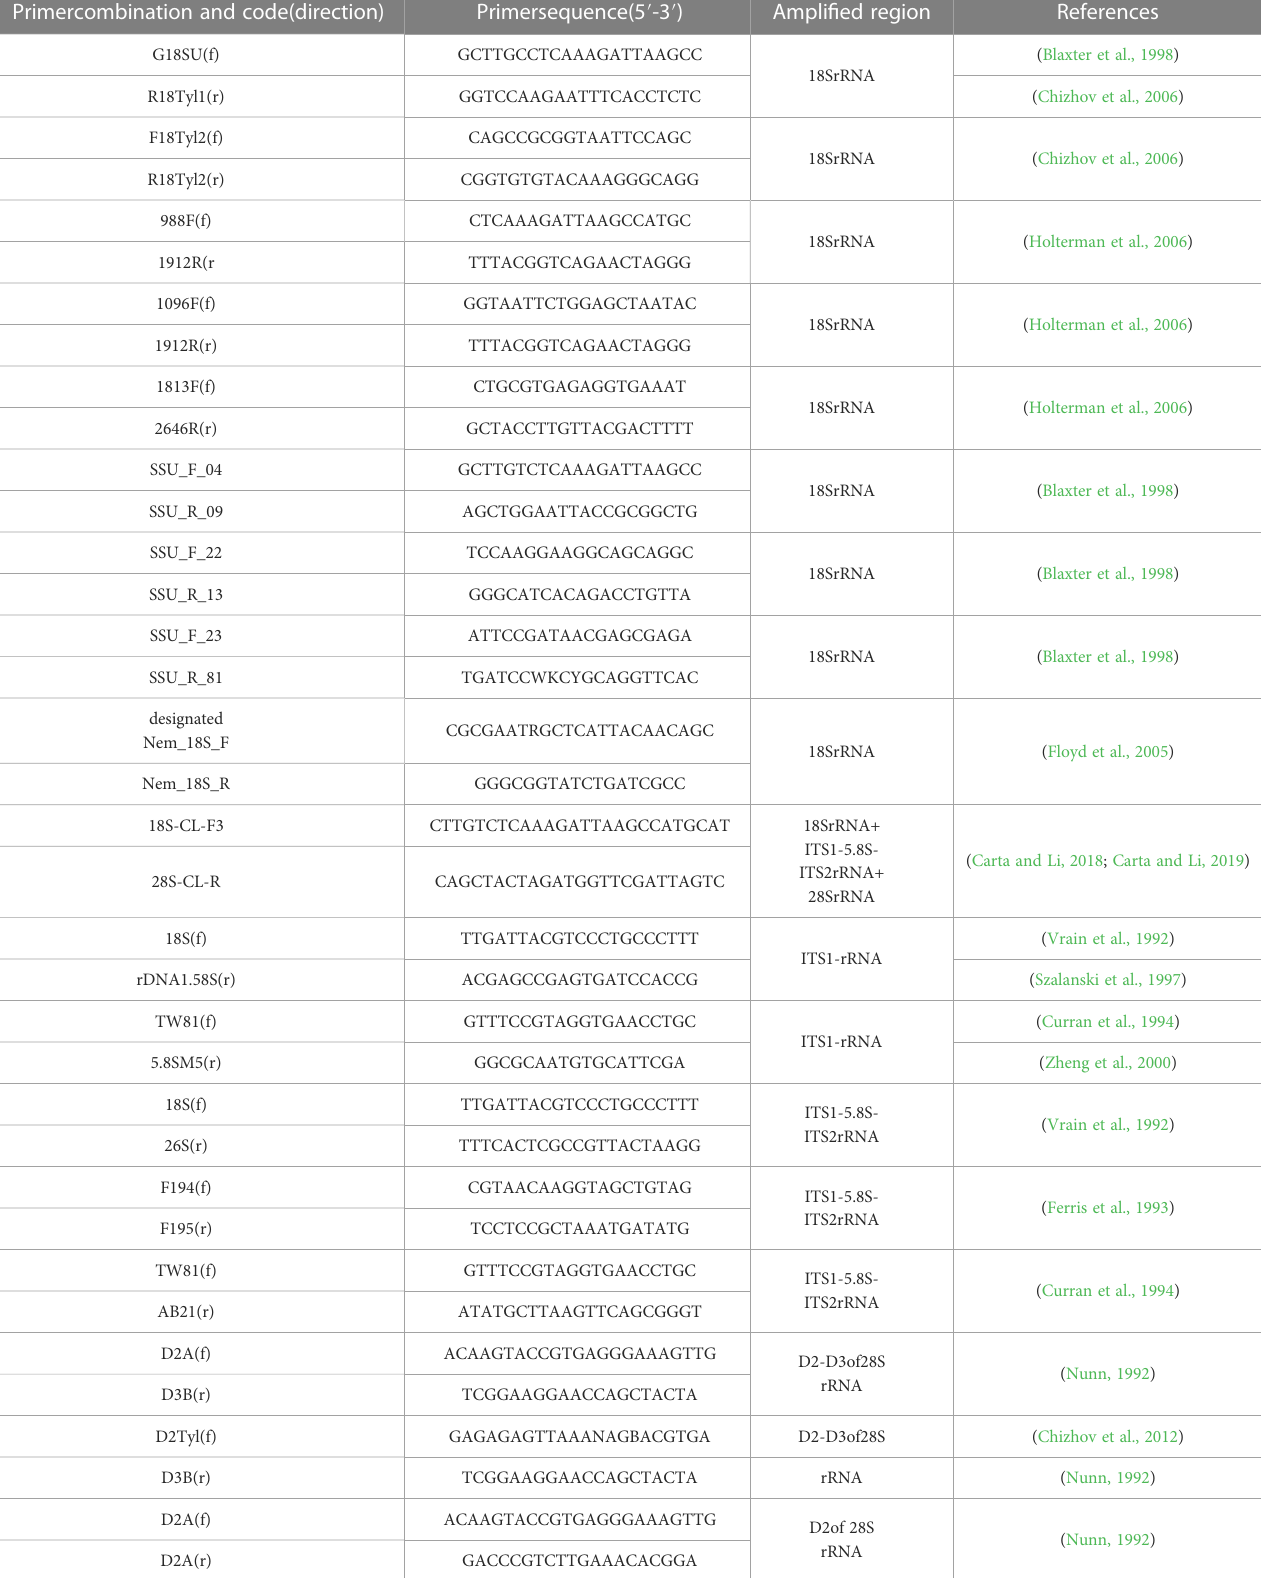
TABLE 1 Some universal primer combinations used for ampli fi cation of ribosomal RNA genes of